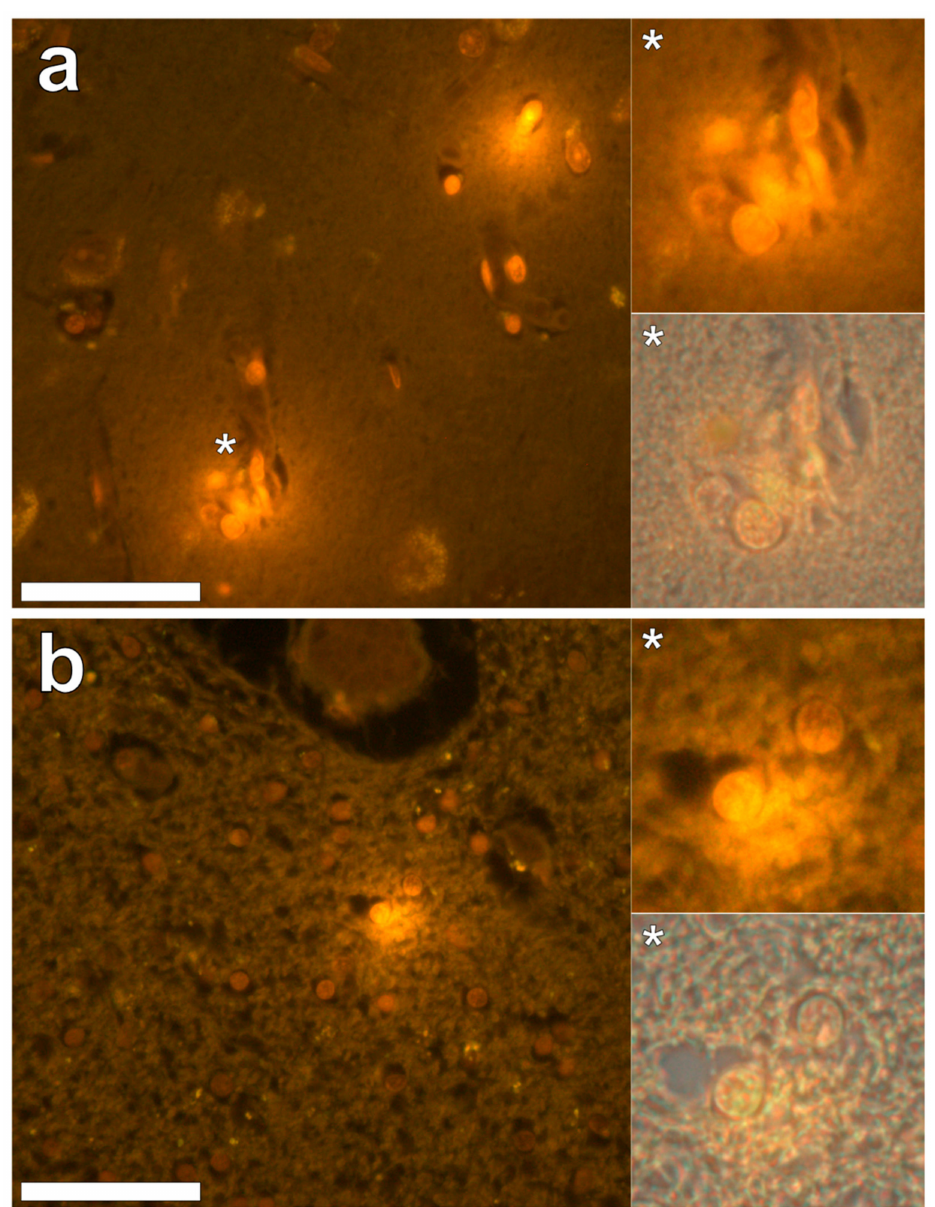
Figure 7. Intracellular lumogallion-reactive aluminium identified in grey and white matter regions of the temporal lobe. Glial cells exhibiting astrocytic-like processes displayed bright orange fluorescence in grey ( a ) and white ( b ) matter regions. Magnified inserts are denoted by asterisks with lower panels including a bright field overlay. Magnification 400 × ; scale bars 50 µ